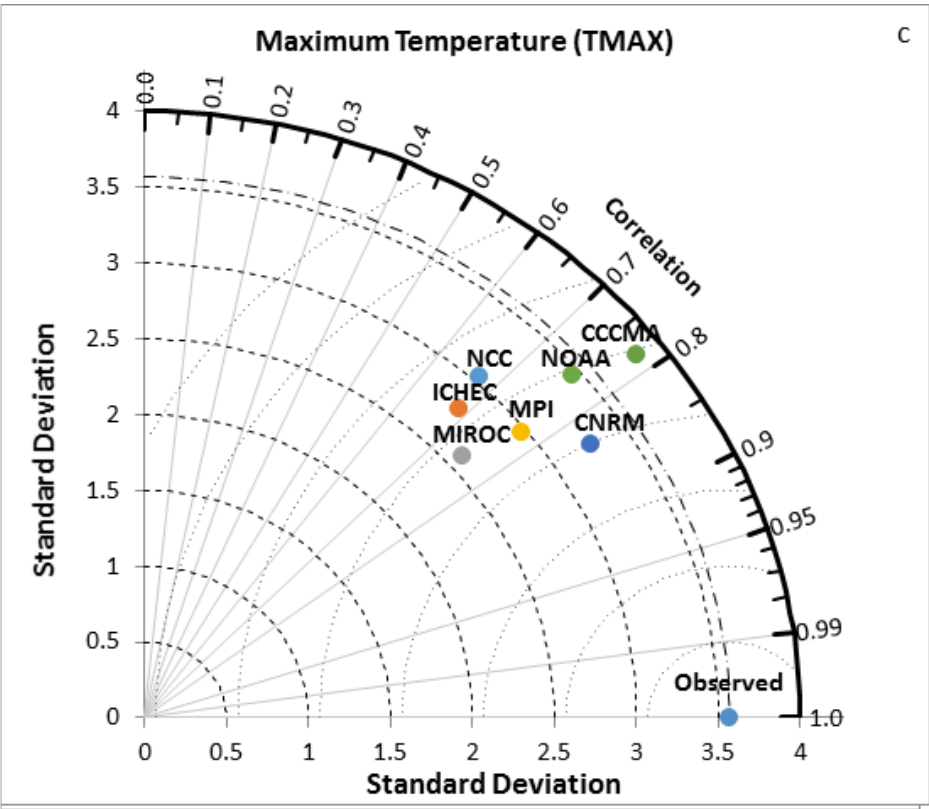
Figure 3. Taylor Diagram to compare the seven models and their combinations with respect to the observed data in terms of correlation coefficient and standard deviation. ( a ) for precipitation, ( b ) for minimum temperature, and ( c ) for maximum temperature.